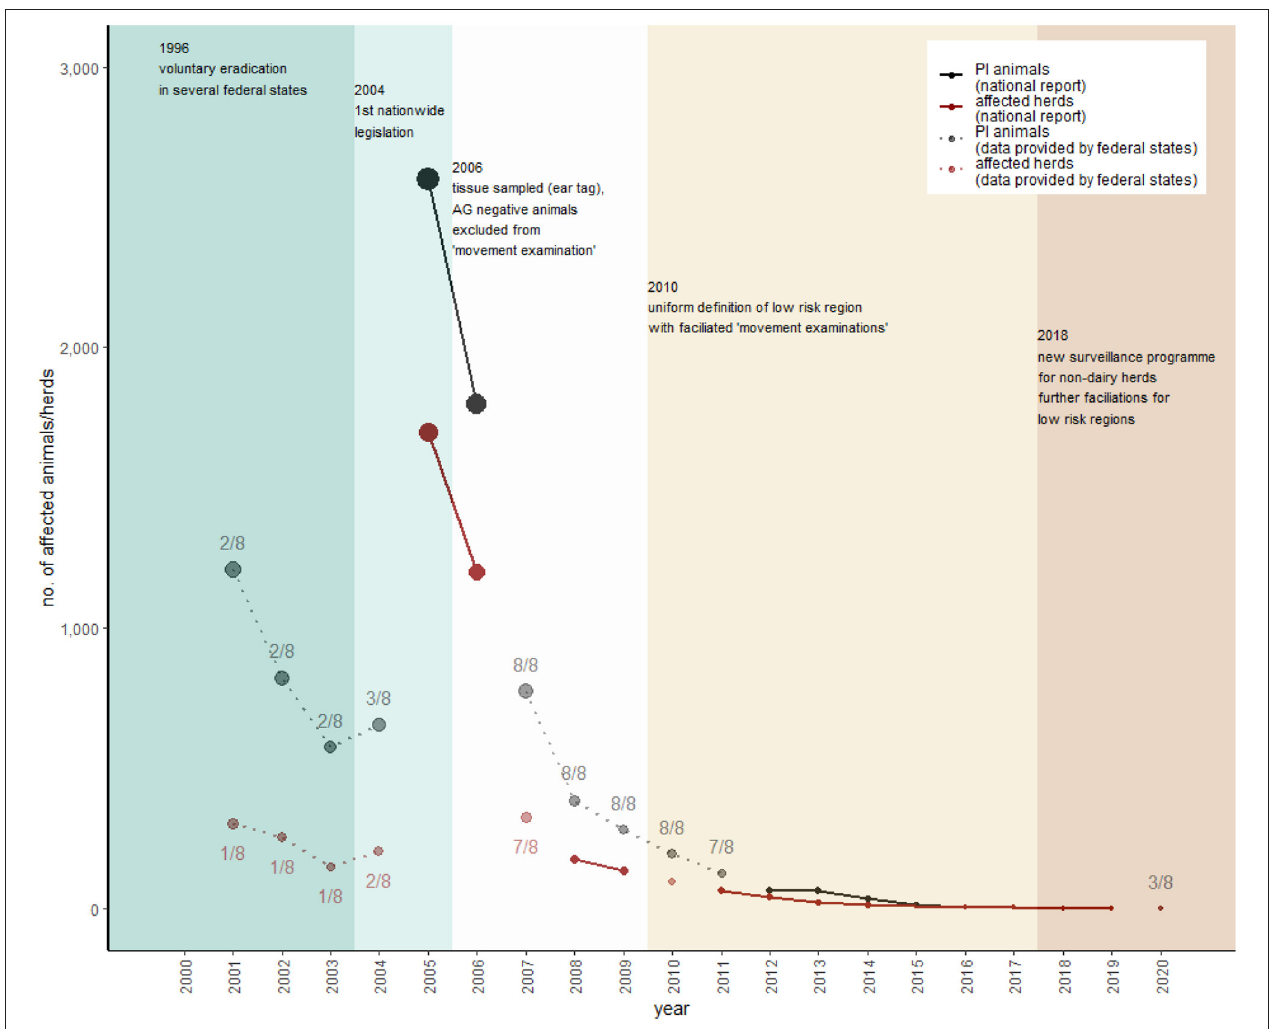
FIGURE 5 | Overview of the historical development of BVD control in Austria. National report data of persistently infected (PI) animals are represented as black dots and herds with PI animals as dark red dots. These data are not consistently available over the period. Missing data were supplemented with federal state data upon our request, represented as lighter dots. To provide an estimation of how representative these federal state data are, the numbers of federal states (out of eight) are included in each data point as a number (detailed data of the individual federal states are presented in Supplementary Figure 2 ). The most important changes in legislation with consequences for the sampling strategy represent the different colors within the